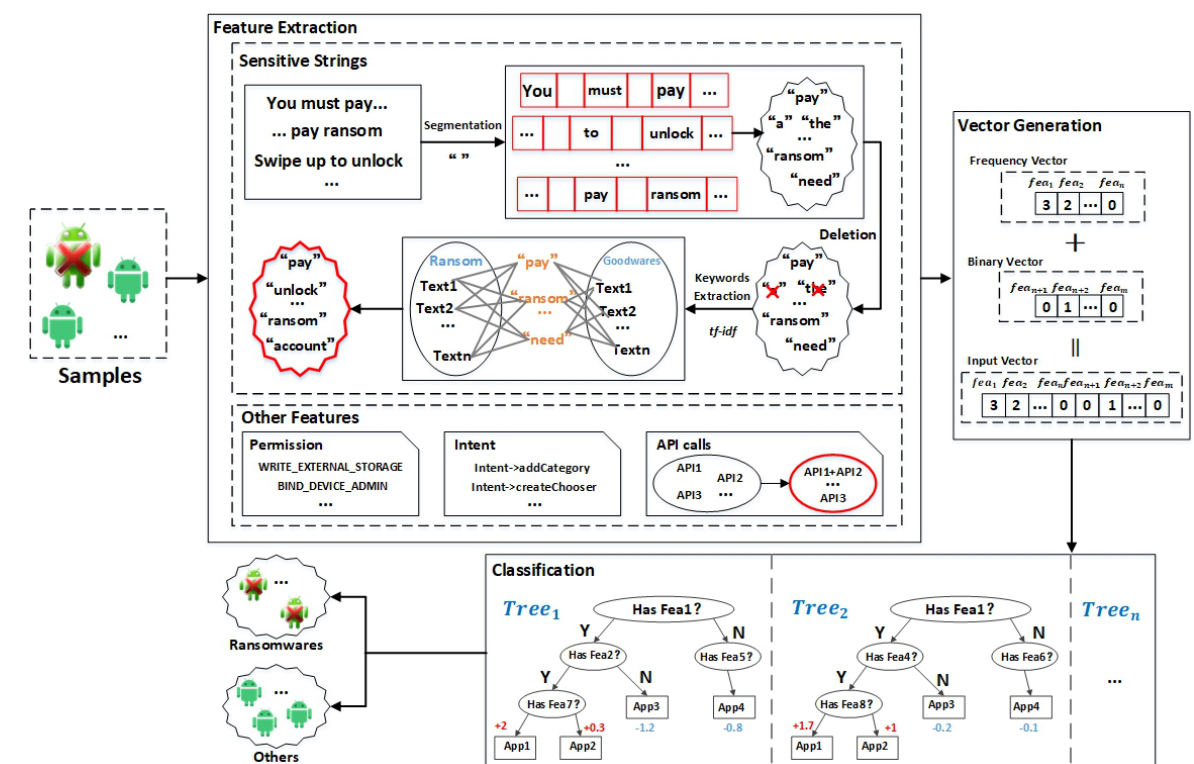
Figure 4. Workflow of the behavior-based, ransomware-oriented